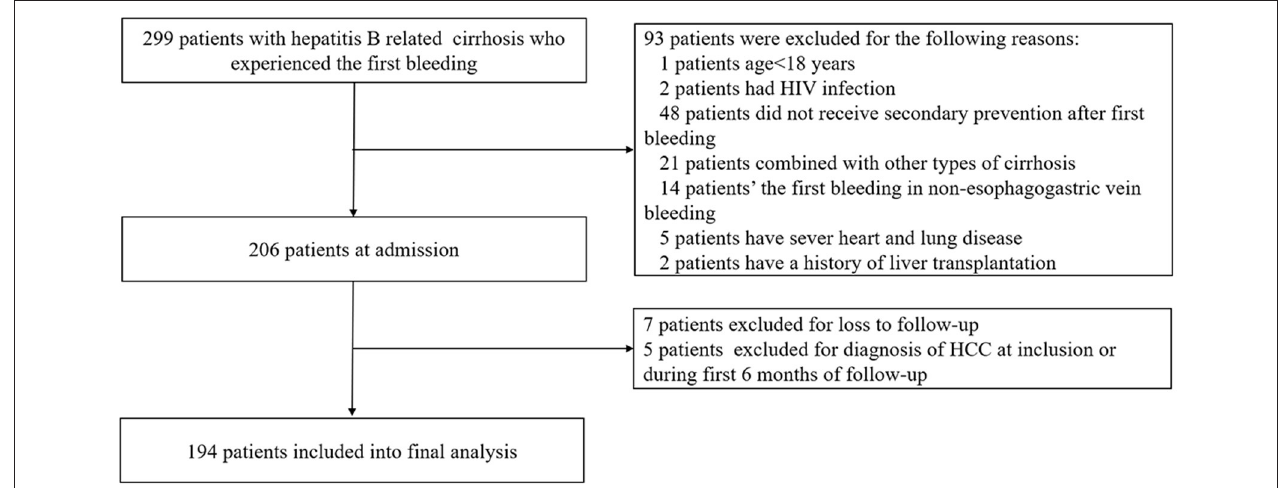
FIGURE 1 | The flowchart of our